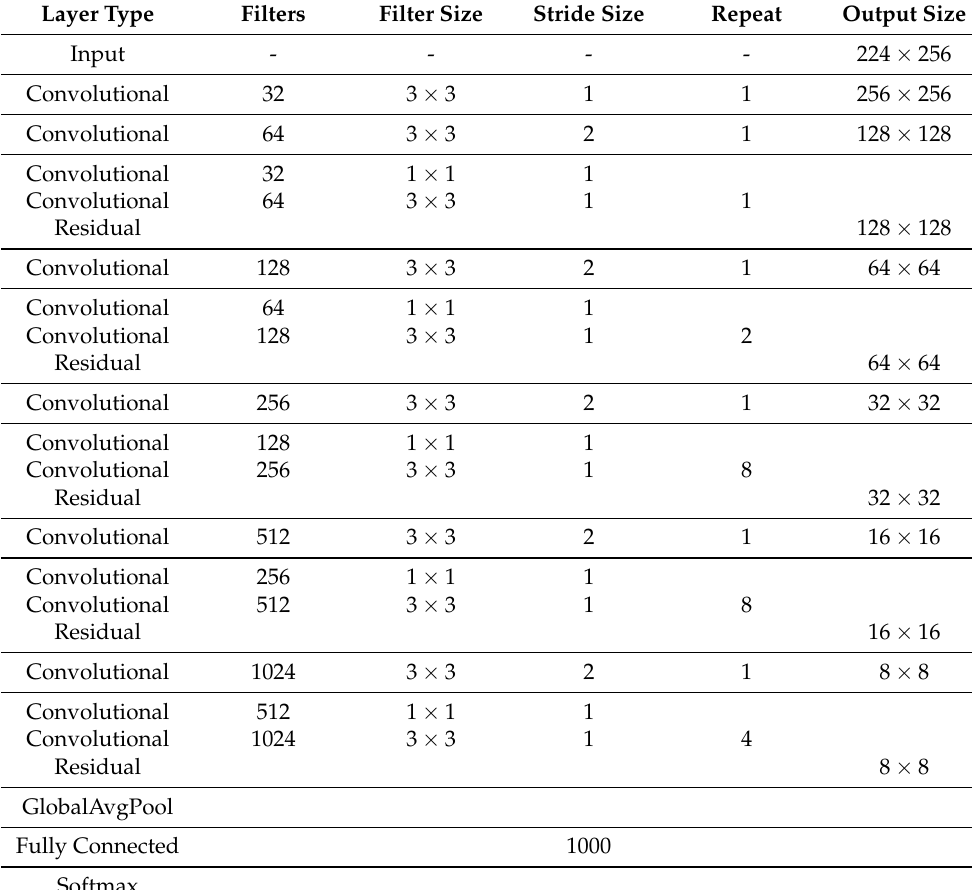
Table 1. DarkNet53 layer